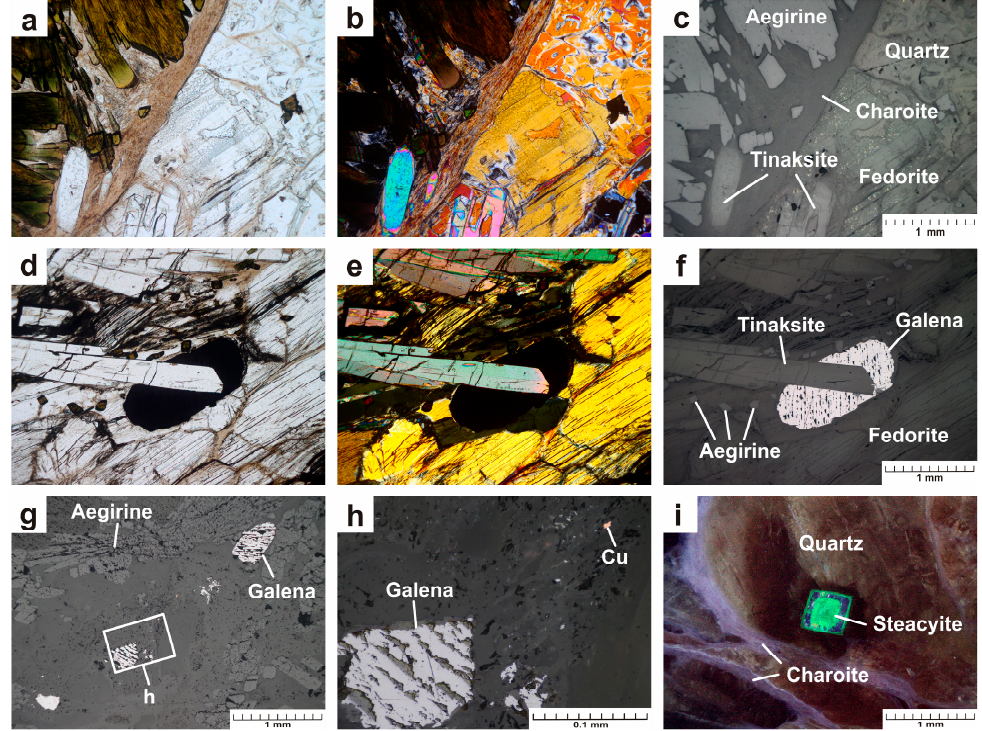
Figure 6. Polished thin section image of the sample Irk-53 in transmitted ( a , b , d , e ) and reflected ( c , f , g , h ) light, and with ultraviolet radiation of 254 nm ( i ); ( a,c,d,f,g,h,i )—polarizers are parallel, ( b,e )—polarizers are crossed. The interference color corresponds to a thickness of thin section (~40 μ m).